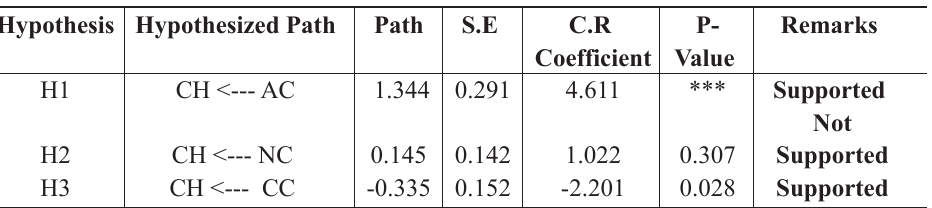
Structural regression analysis (SEM) was run to check the following Hypothesis paths; Table no.5 shows the results of Hypothesis Table 5: SEM Hypothesis Testing